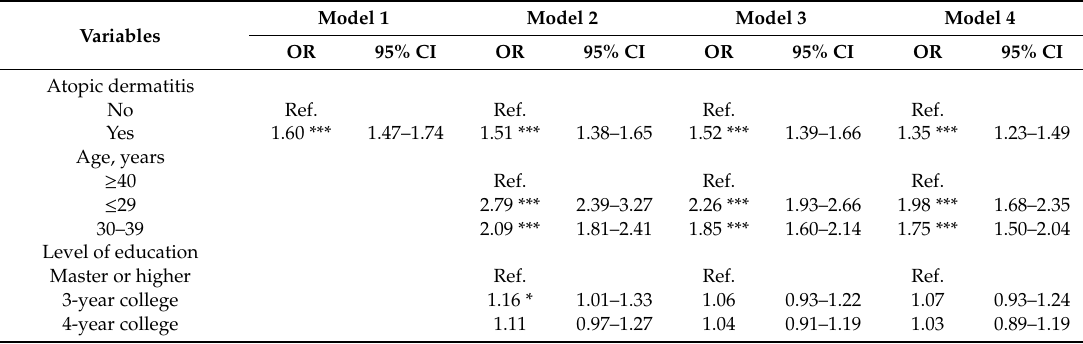
Table 4. Odds and 95% confidence interval for sleep disturbance in the multivariate logistic regression analysis ( N =